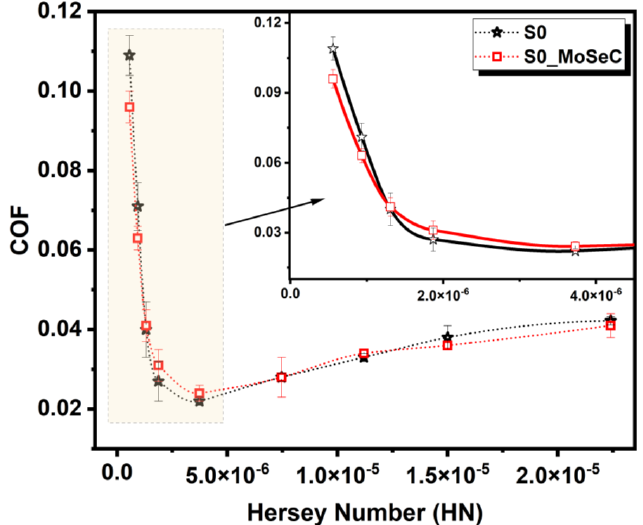
Figure 4. Stribeck curves for the S0 and S0_MoSeC specimens.